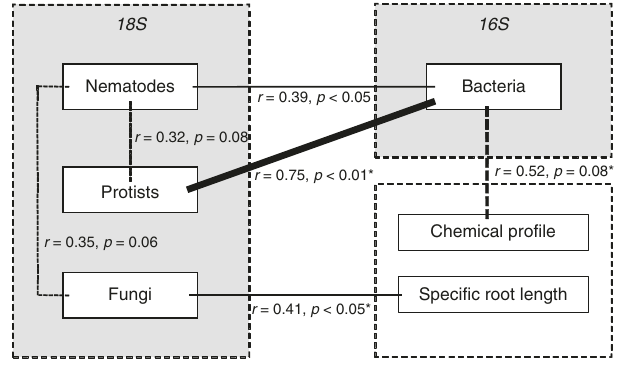
Fig. 2 Correlational links in the rhizosphere. Overview of correlational links (all correlations with p < 0.1 are shown) between rhizosphere community dissimilarities of bacteria, nematodes, protists, and fungi (all based on OTUs; 4 – 5 replicates per species) and between root trait variation (root chemical pro fi le (4 replicates per species), speci fi c root length (3 replicates per species)), and dissimilarities of rhizosphere communities. Signi fi cant correlations (based on Mantel tests) are depicted with solid lines, whereas trends ( p > 0.05, < 0.10) are depicted with dashed lines. Line thickness represents the relative strength of the correlational link based on r -values. Links that are signi fi cant based on a structural equation model (Supplementary Fig. 7) are represented with asterisks (*). Source data are provided as a Source Data fi